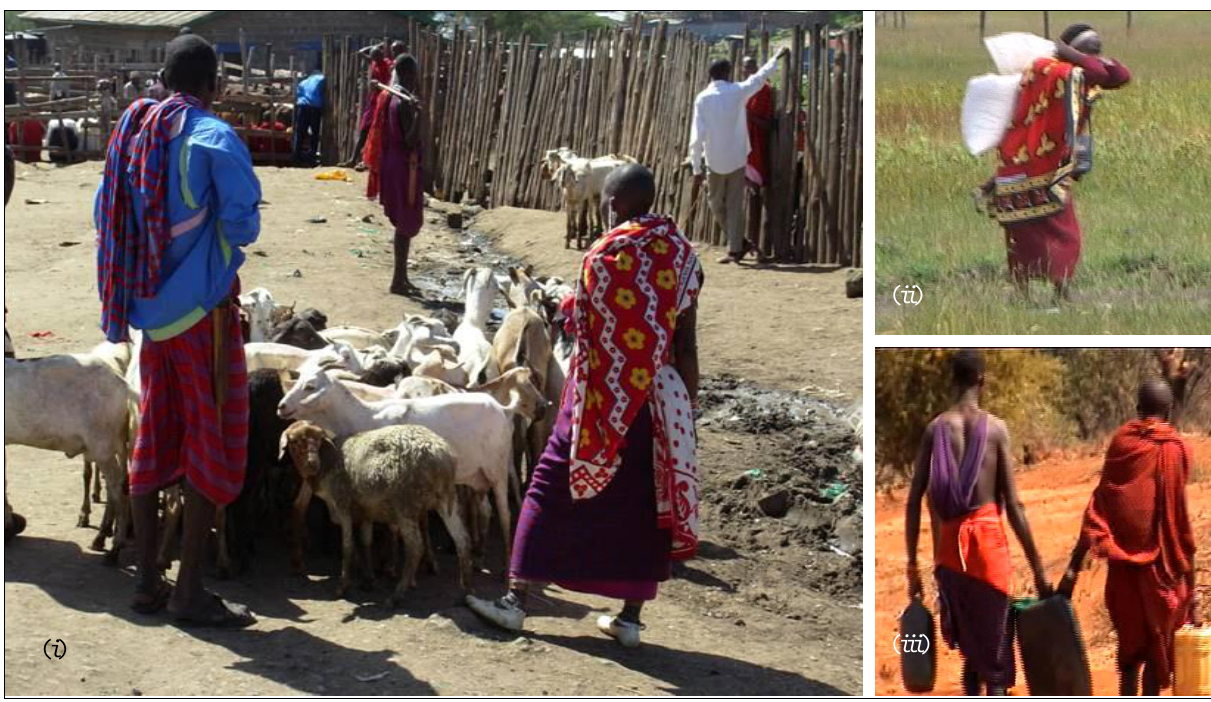
Fig. 3. Portraits of drought-adaptations presently utilized in Maasai-pastoralism (i) a young Maasai couple selling sheep and goats (shoats) at a local terminal livestock-market; (ii) a Maasai woman enroute home carrying a bag of relief-food (yellow maize grain) received from a distant trading center; and (iii) men helping fetch water for livestock and for domestic needs; and sometimes sell to small-scale traders, from distant well during the extreme- drought that plagued the region in